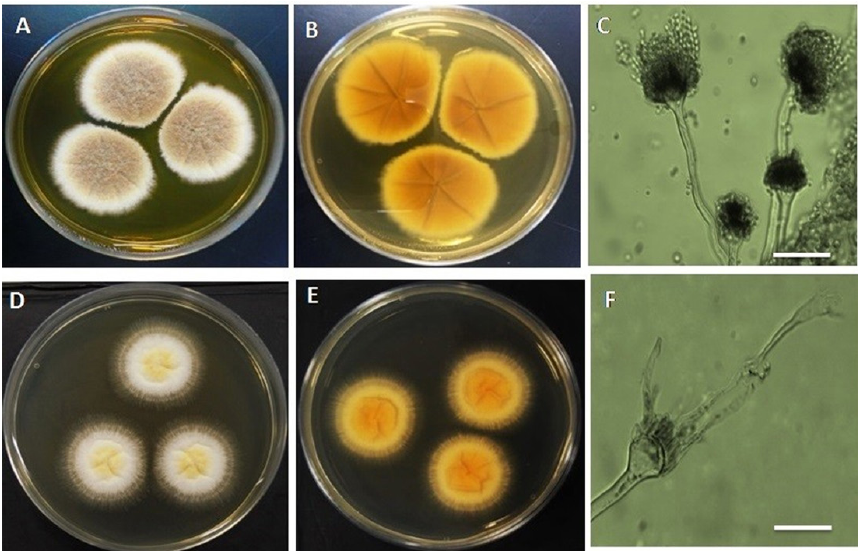
Fig. 1. Aspergillus terrues A&B. Surface and reverse on MEA C. conidiophore with conidial head D&E. Surface and reverse on YES agar F. Conidiophores with immature vesicle (Bar in C & F = 100 µ